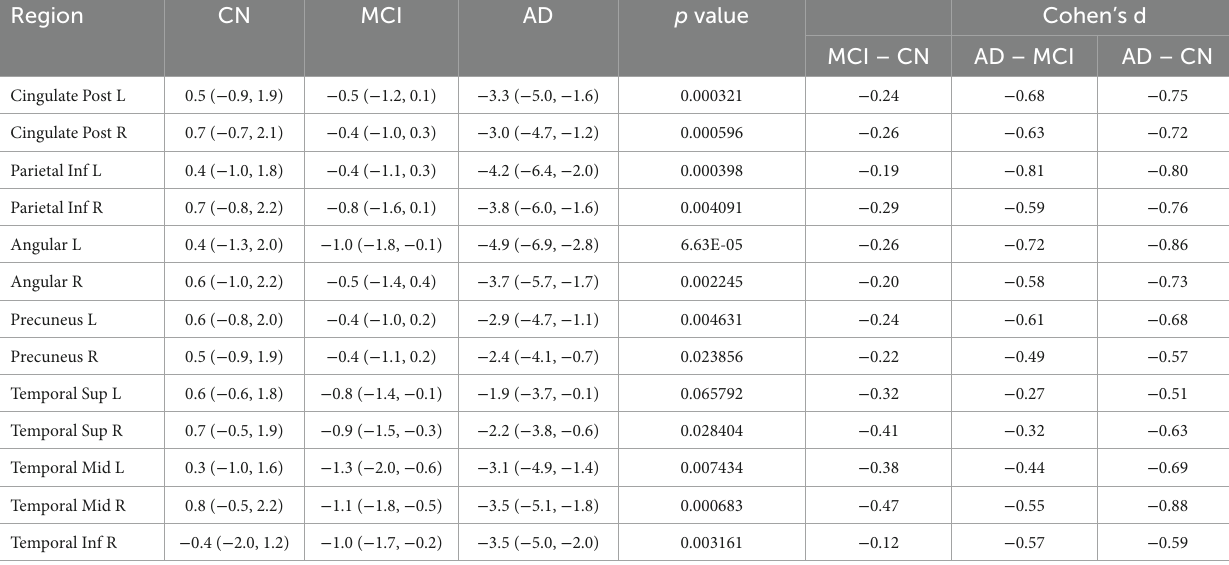
TABLE 3 Comparisons of FDG-PET progression rates between CN, MCI and AD in the longitudinal analysis. Region CN MCI AD p value Cohen’s d